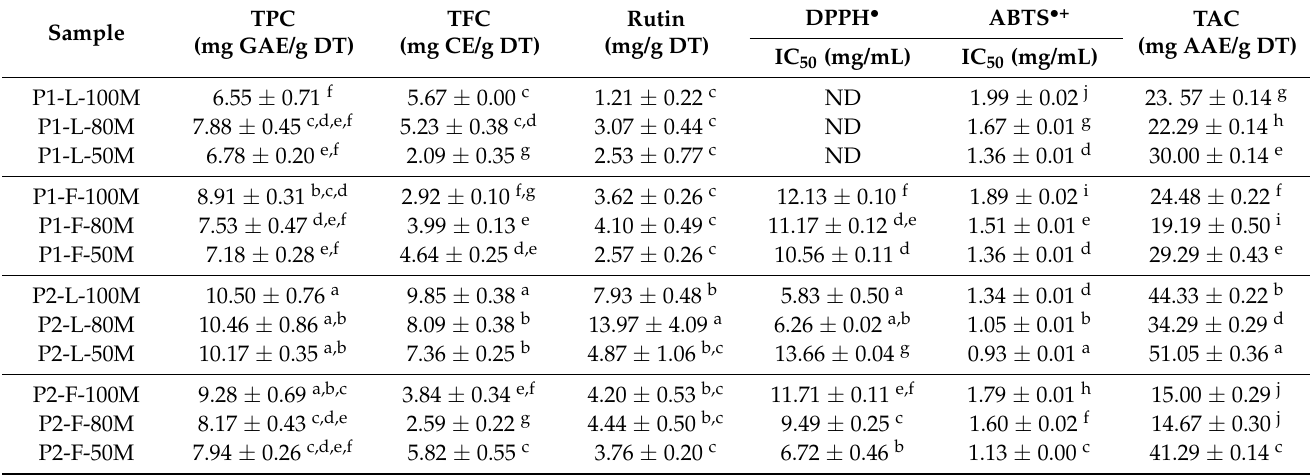
Table 1. Total phenolic, flavonoid, and rutin contents, free radical scavenging activity, total antioxidant capacity, and antibacterial activity of methanolic extracts from leaves and flowers of Verbesina sphaerocephala .